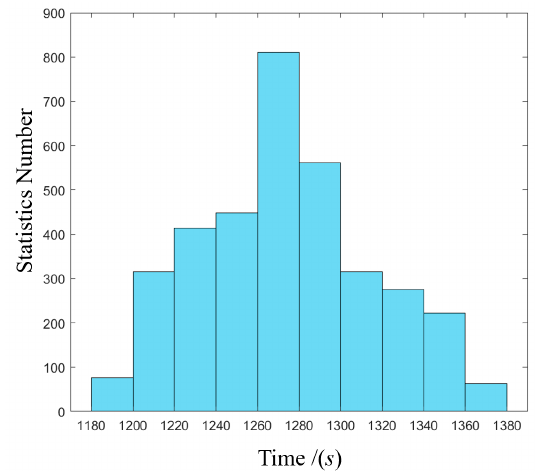
Figure 6. The statistics of flight time.